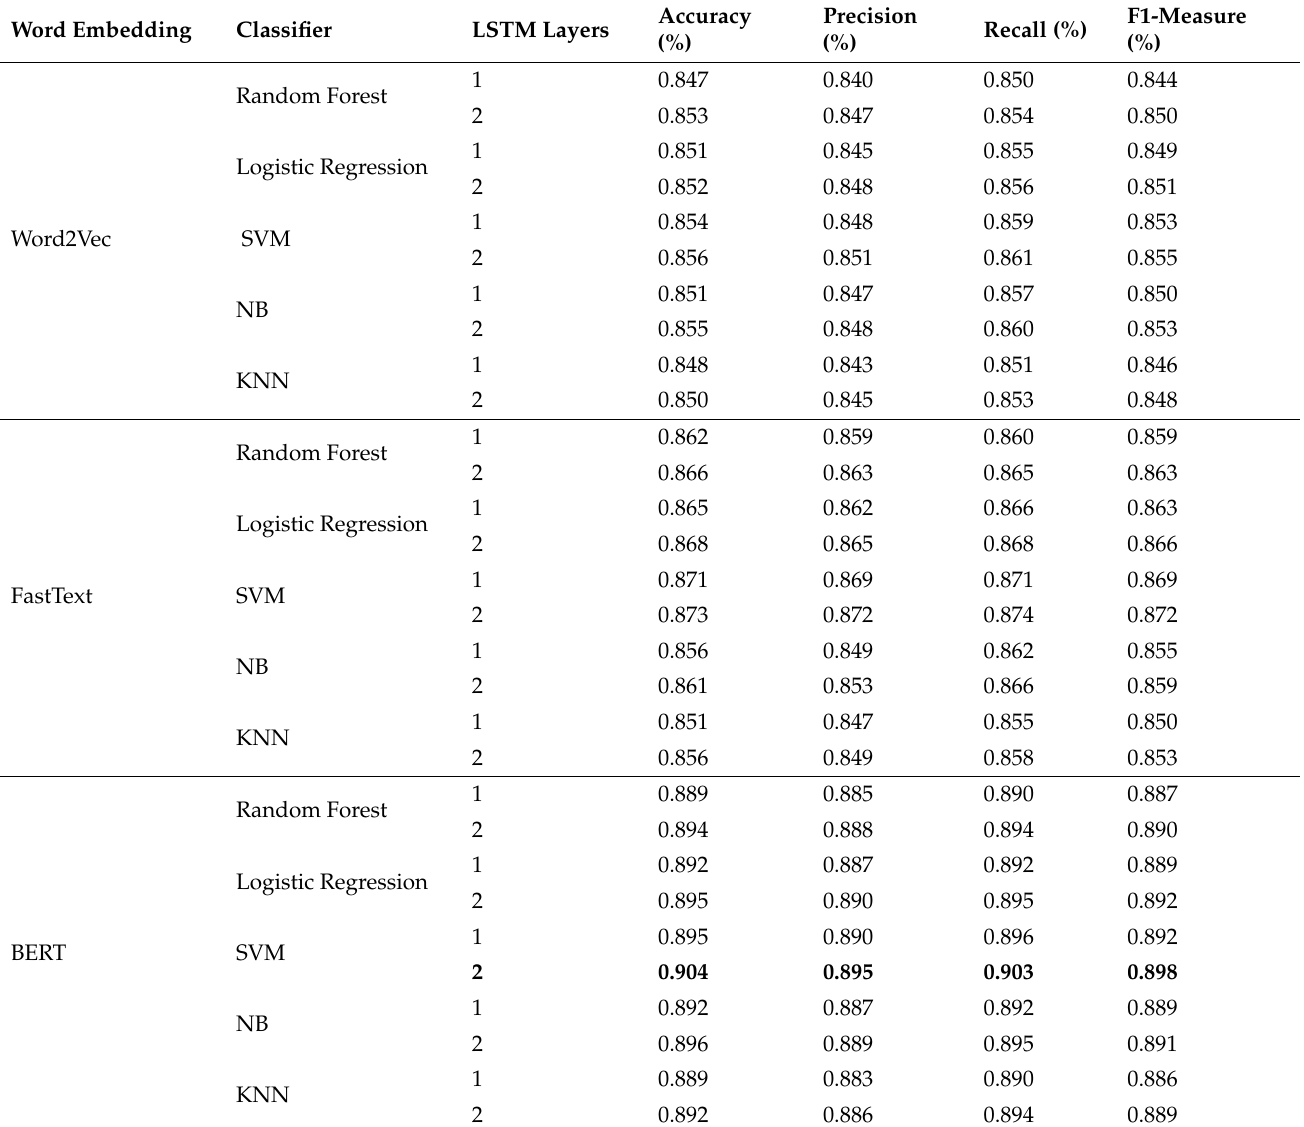
Table 8. CNN-LSTM model accuracy using various word embeddings with two-layer LSTM using IMDb movie reviews